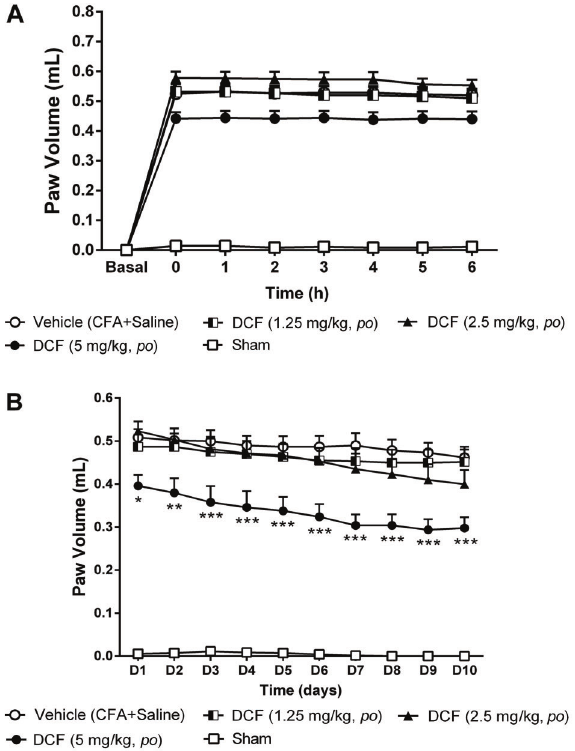
Figure 6. Effect of acute ( A ) and chronic ( B ) administration of diclofenac (DCF) on the paw edema induced by Freund ’ s complete adjuvant (CFA) in female Wistar rats (n=6 – 8). Each point represents the mean ± SEM of the paw volume (mL) before CFA injection (i.e., baseline) or at the times indicated thereafter. *P o 0.05, **P o 0.01 and ***P o 0.001 compared to vehicle group (two-way ANOVA, Bonferroni